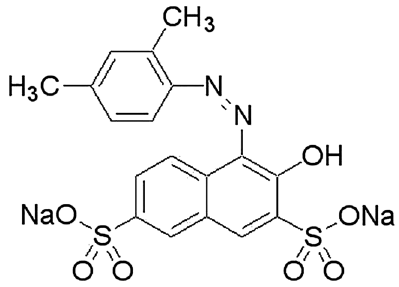
Figure 2: Chemical formula of XP 2R.